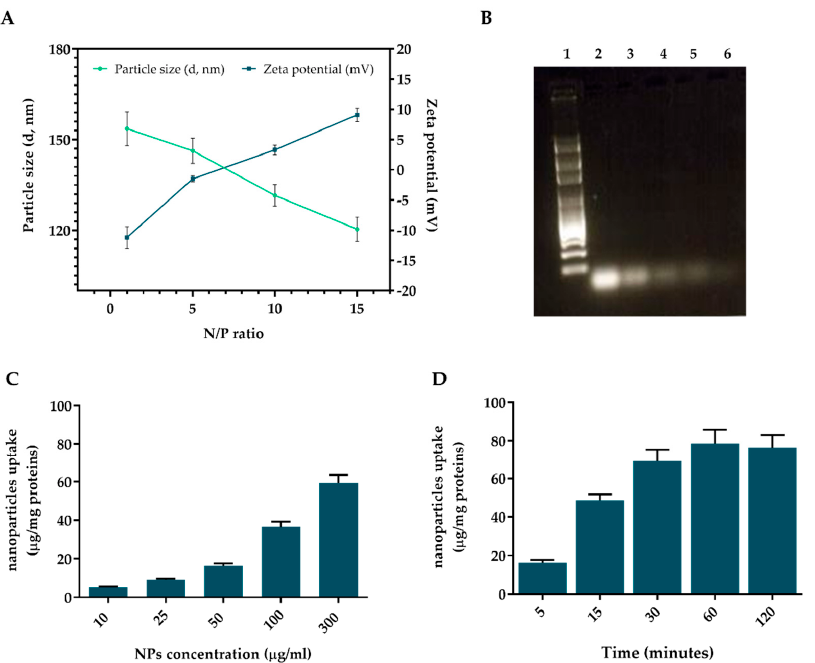
Figure 2. Characterization of siRNA/AcPEI complexes. ( A ) Average hydrodynamic diameter and zeta potential of AcPEI NPs at different N/P ratios (mean ± SD, n = 6). ( B ) Nuclease stability of siRNA/AcPEI complexes at different N/P ratios after incubation at 37°C and 5% CO 2 in 90% FBS. After gel electrophoresis, band intensities were quantified with ImageJ software and plotted versus time. Free MMP2-siRNA was used as control. Line 1: marker, line 2: free siRNA, line 3: N/P 1:1, line 4: N/P 5:1, line 5: N/P 10:1, and line 6: N/P 15:1. Uptake efficiency of fluorescent nanocomplexes (siRNA/AcPEI) in human prostate cancer cells PC3 at N/P ratio of 15:1. ( C ) Concentration and ( D ) time dependent cellular uptake of siRNA/AcPEI performed by FACS analysis. Cell-associated fluorescence was calculated from the standard curve and expressed as the number of nanoparticles ( μ g) uptaken per mg cell protein. Results are expressed as the mean of three independent experiments ± standard deviation (n =